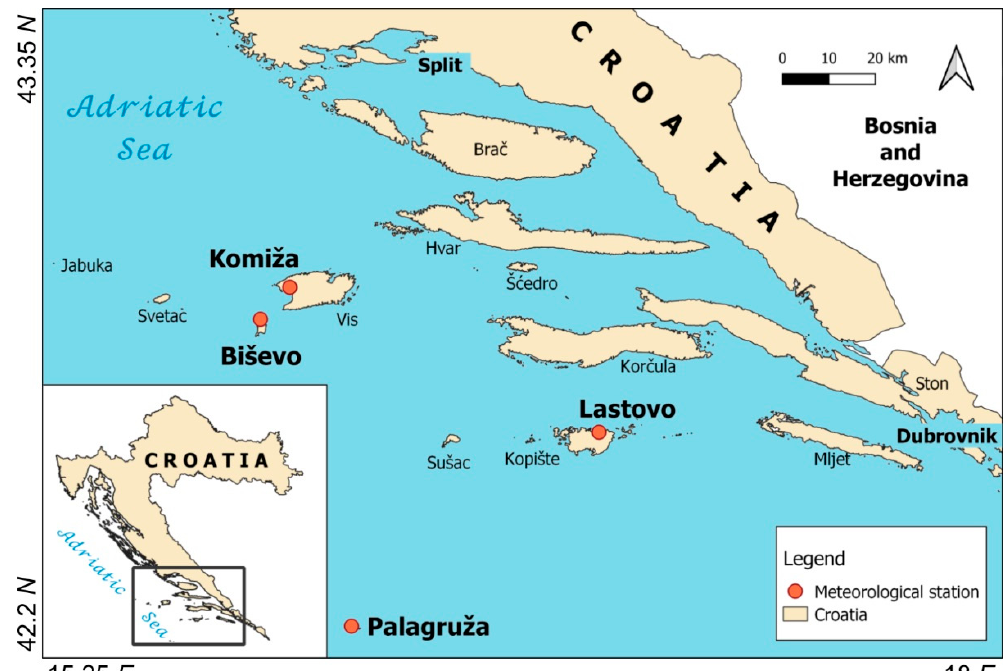
Figure 1. Map of the study area showing the locations of the four meteorological stations whose data were analyzed in this work.